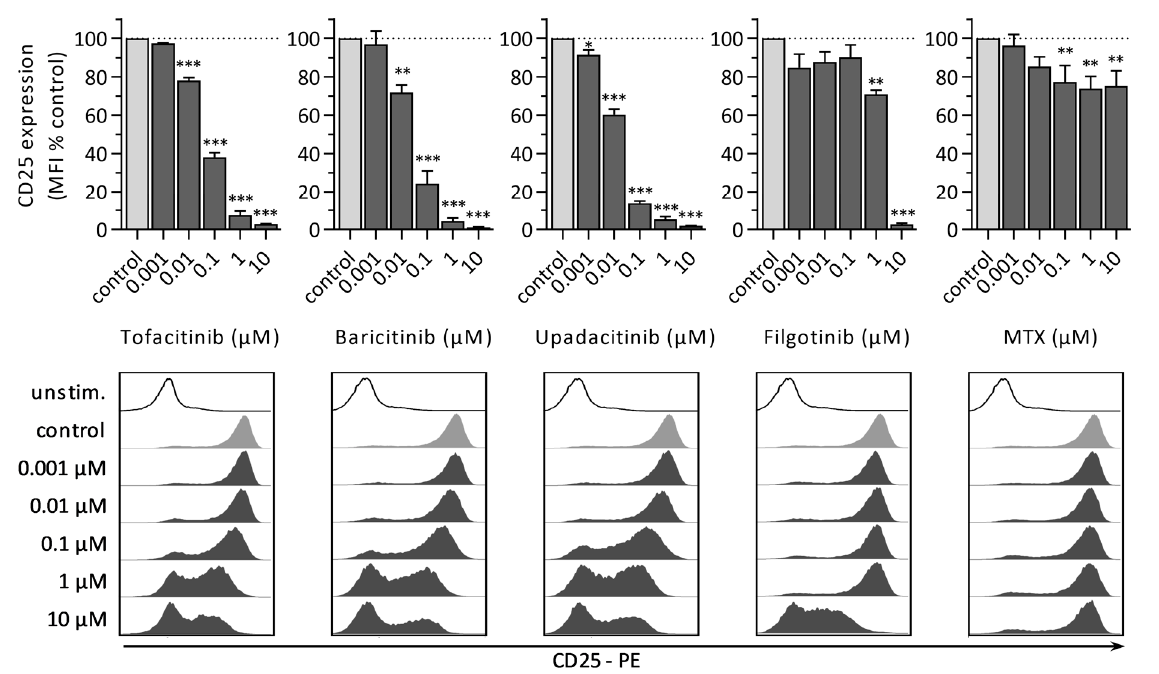
Figure 3. Assessment of lymphocyte activation by CD25 expression 48 h after PHA-stimulation and combined treatment of indicated JAKi or MTX concentrations. Median fluorescence intensity of CD25 expression was quantified. Diagrams display the mean ± SEM of three independent experiments (*** p ≤ 0.001; ** p ≤ 0.01; * p ≤ 0.05). Representative histograms of CD25 intensity are shown below.